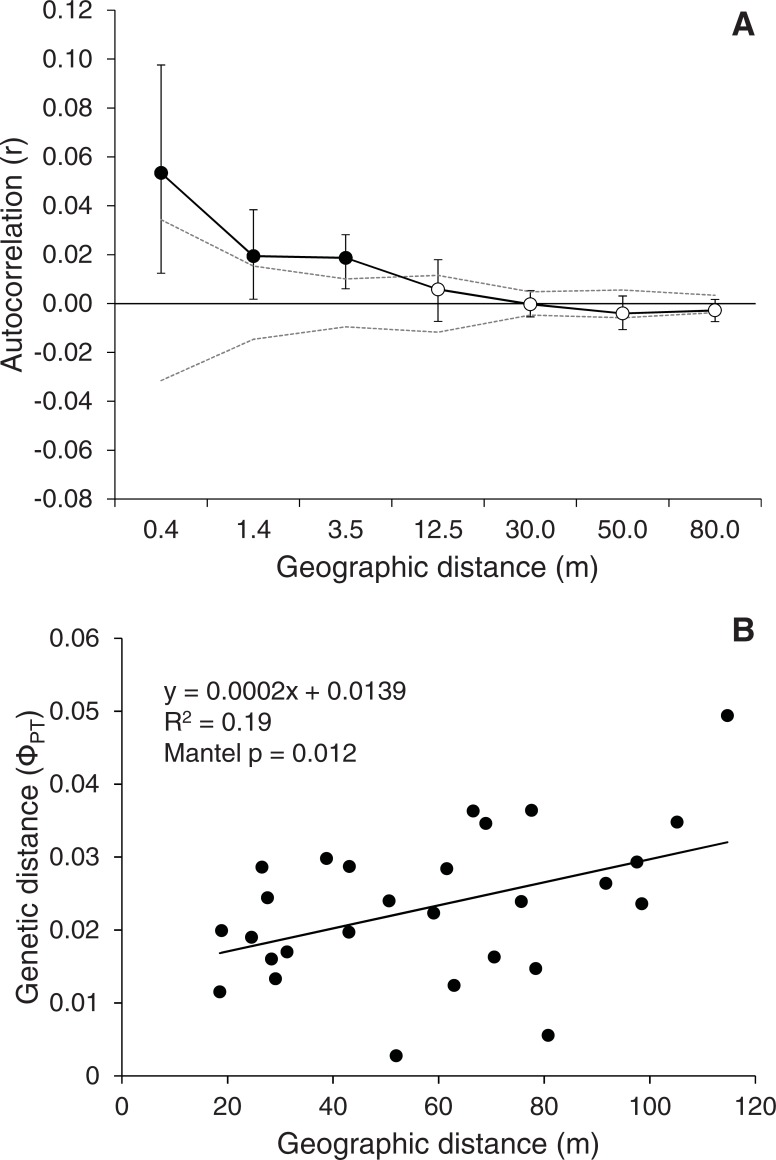
Spatial genetic analysis for Cistus ladanifer at the unburned plots (EC-, EC- add).A) Spatial autocorrelogram showing mean r-values per distance class. Filled symbols indicate significant spatial autocorrelation. Dashed lines represent 95% confidence intervals as determined by 9,999 permutations; symbols outside of confidence intervals indicate significance. Error bars depict the 95% confidence interval as determined by 1,000 bootstrap resampling. B) Genetic distance, expressed as pairwise ФPT among plots, vs. geographic distance.